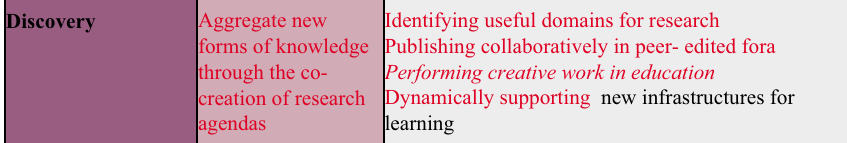
Figure 6. Discovery ‘type’ Scholarship